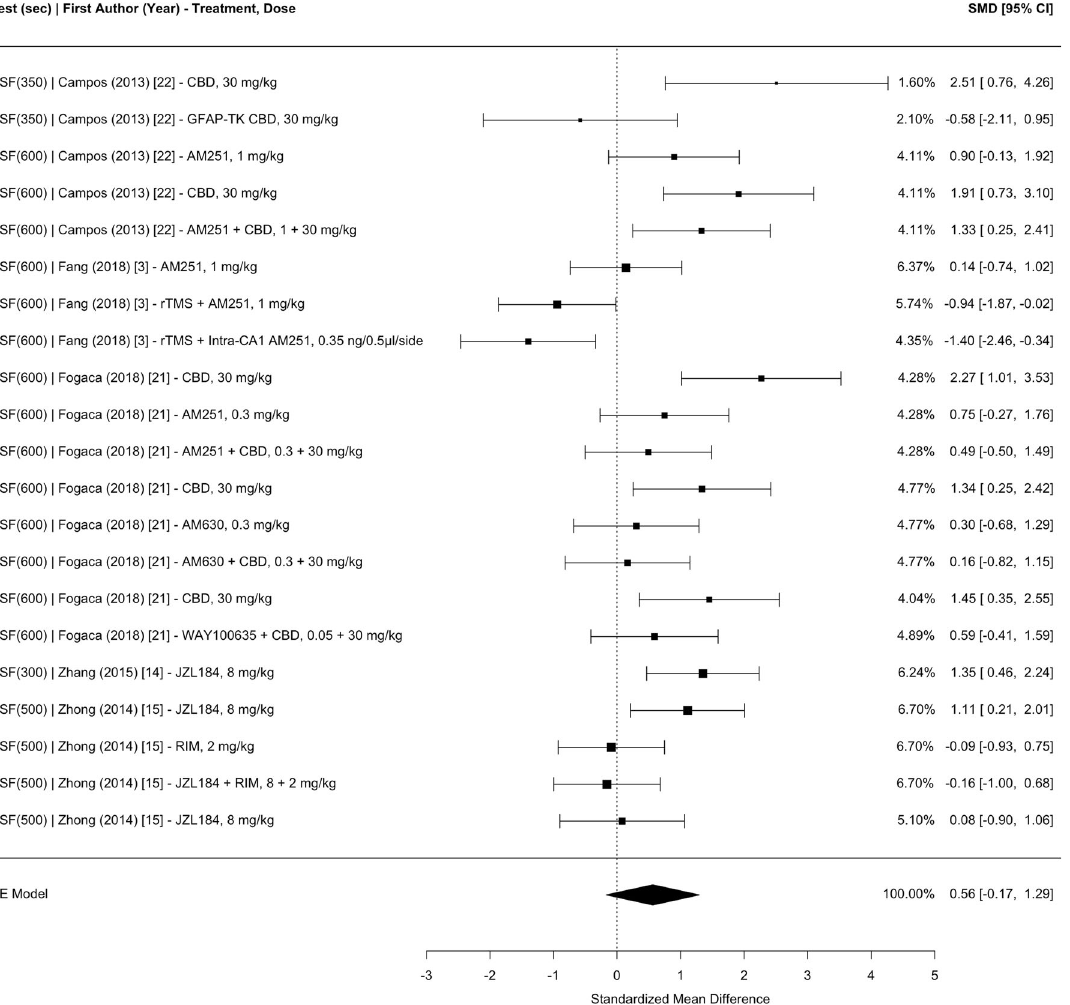
Fig. 4 Meta-analysis of studies investigating the effect of CB administration on anxiety in the novelty suppressed feeding test (i.e., latency to consume food in a novel environment) in CUS. SMD standardized mean difference, CI con fi dence interval, CBD cannabidiol,